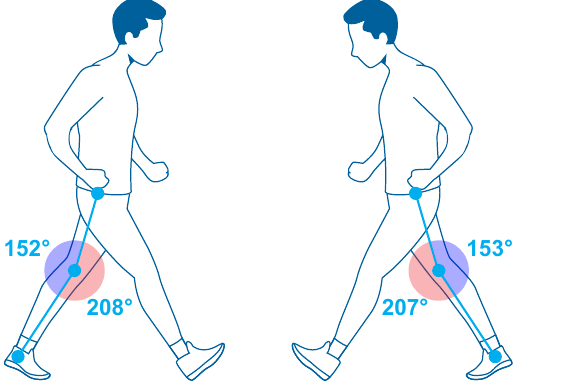
Figure 2. Analysis of flexion angles in the knee: ( left ) conventional socket; ( right ) ergonomic